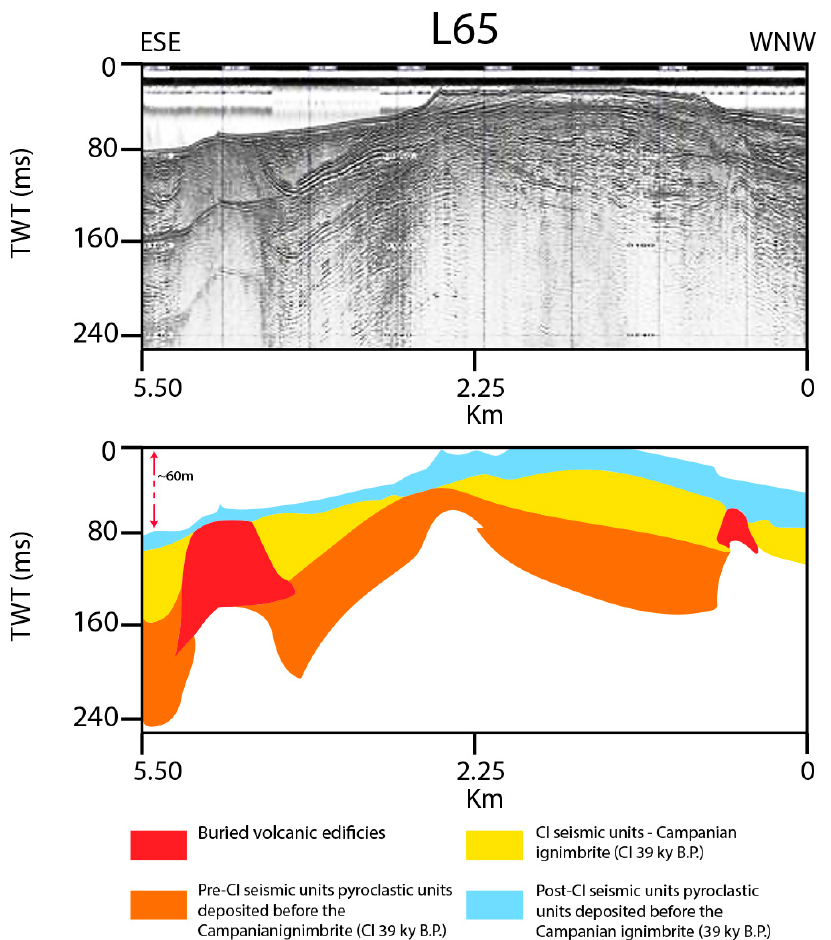
Figure 9. L65 Sparker seismic profile (Procida Channel) and corresponding geologic interpretation.